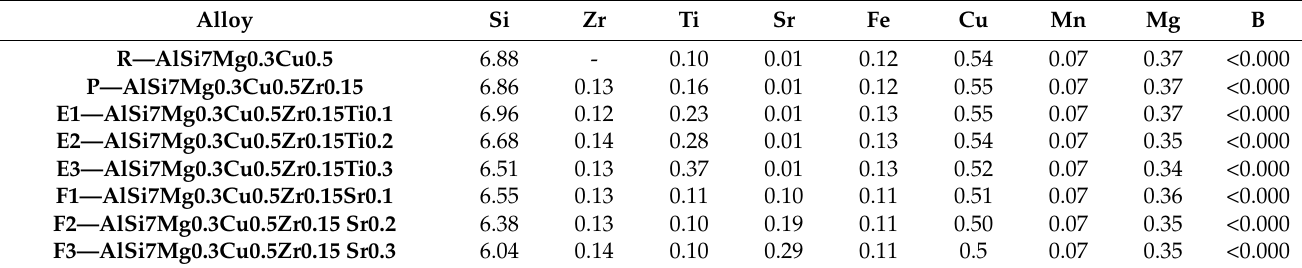
Table 1. Chemical composition of reference, primary, and experimental alloys (wt.